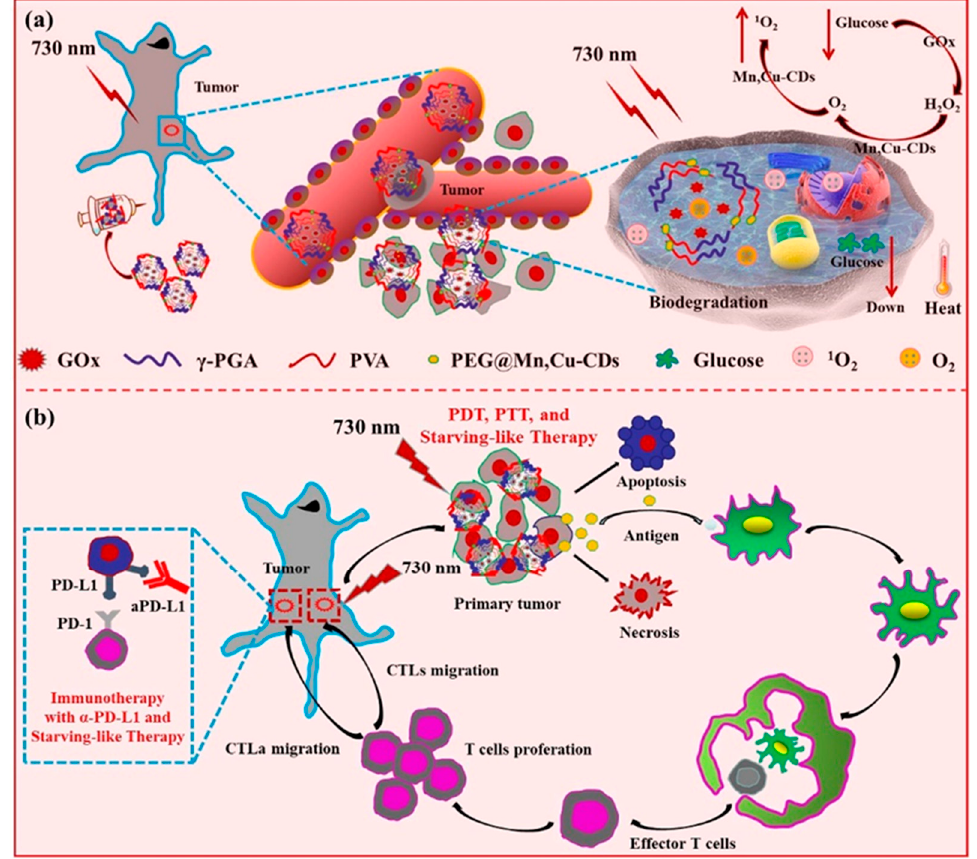
Figure 8. ( a ) Schematic illustration of starving and phototherapy mediated by γ -PGA@GOx@Mn, Cu-CDs NPs. ( b ) Schematic illustration of starving-like therapy, phototherapy, and immunotherapy mediated by γ -PGA@GOx@Mn, Cu-CDs NPs [77]. Copyright 2020, Elsevier.